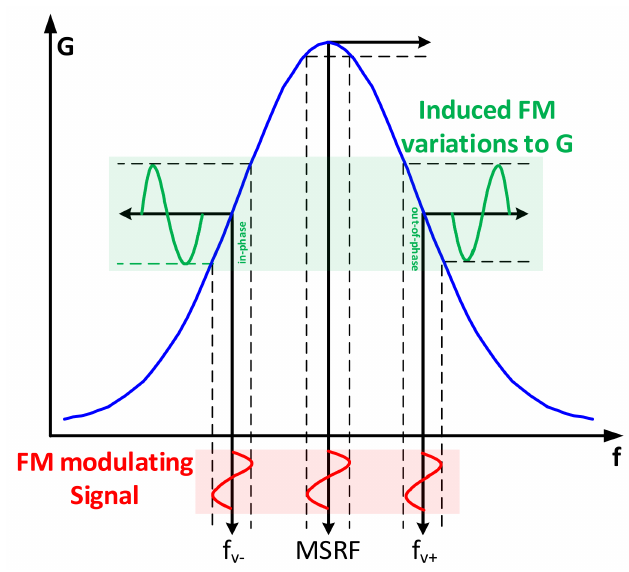
Figure 20. Automatic maximum conductance detection system tuning